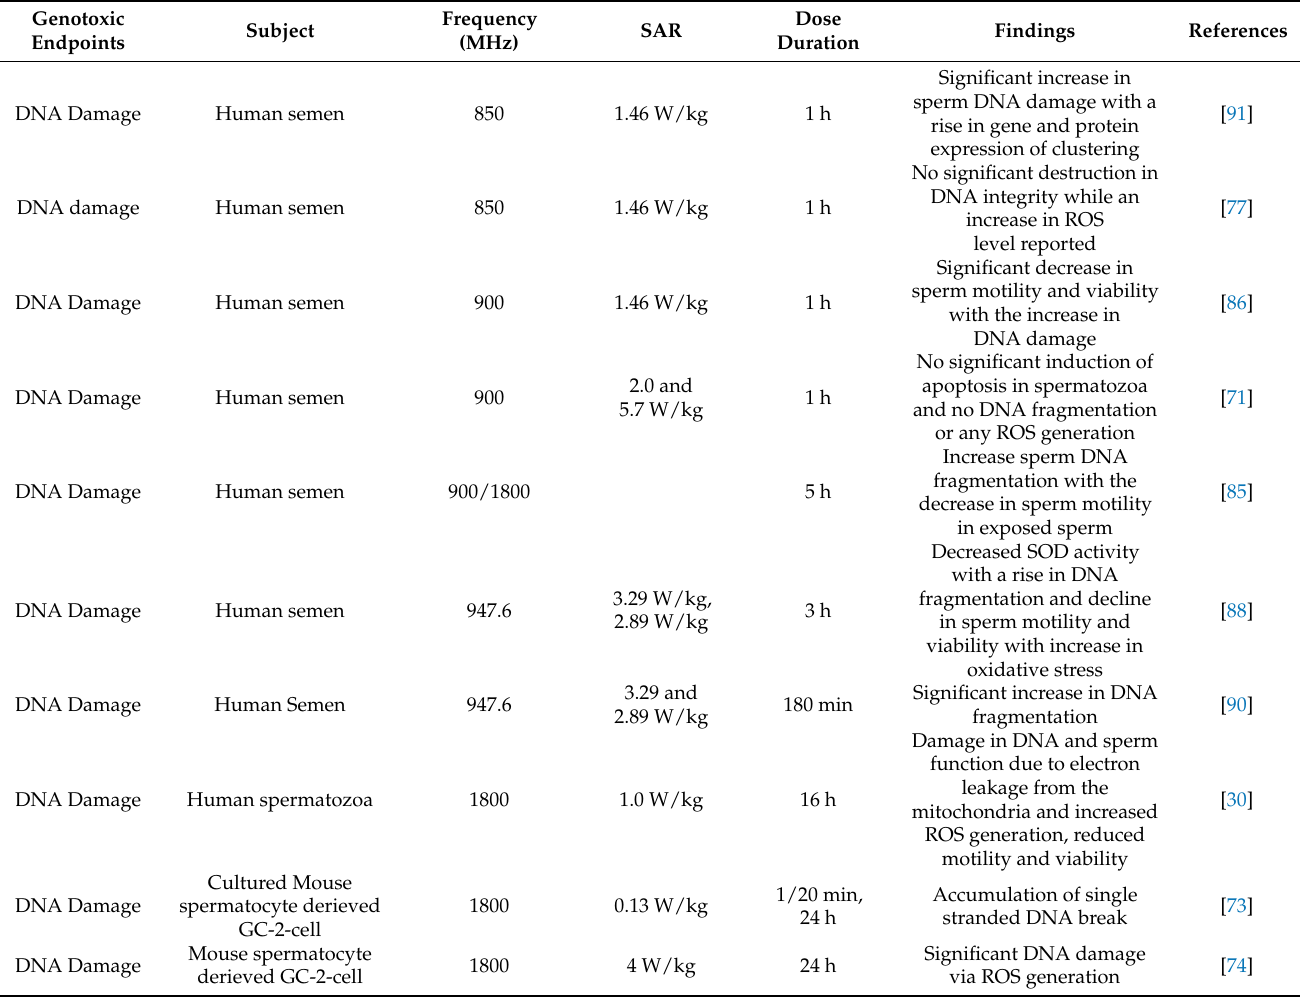
Table 1. In vitro genotoxic studies on male reproductive